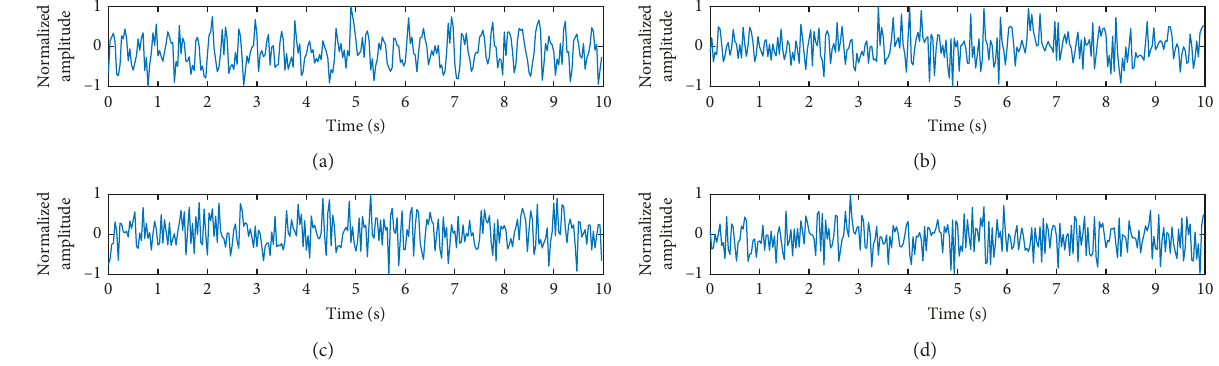
Figure 3: Simulation signals generator